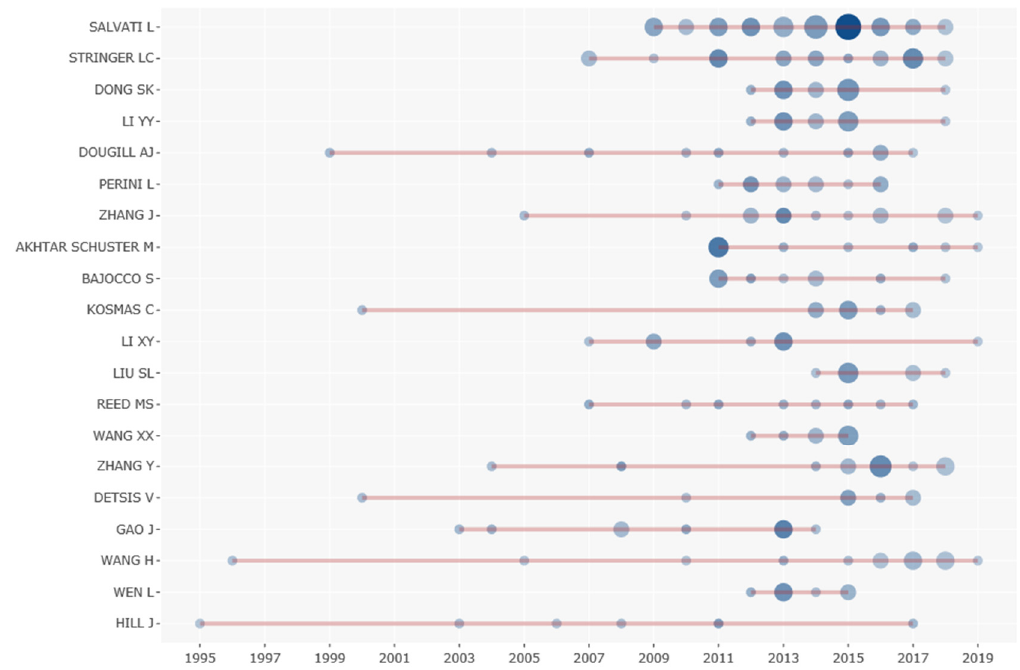
Figure 5. Authors’ production over time in the field of land degradation.